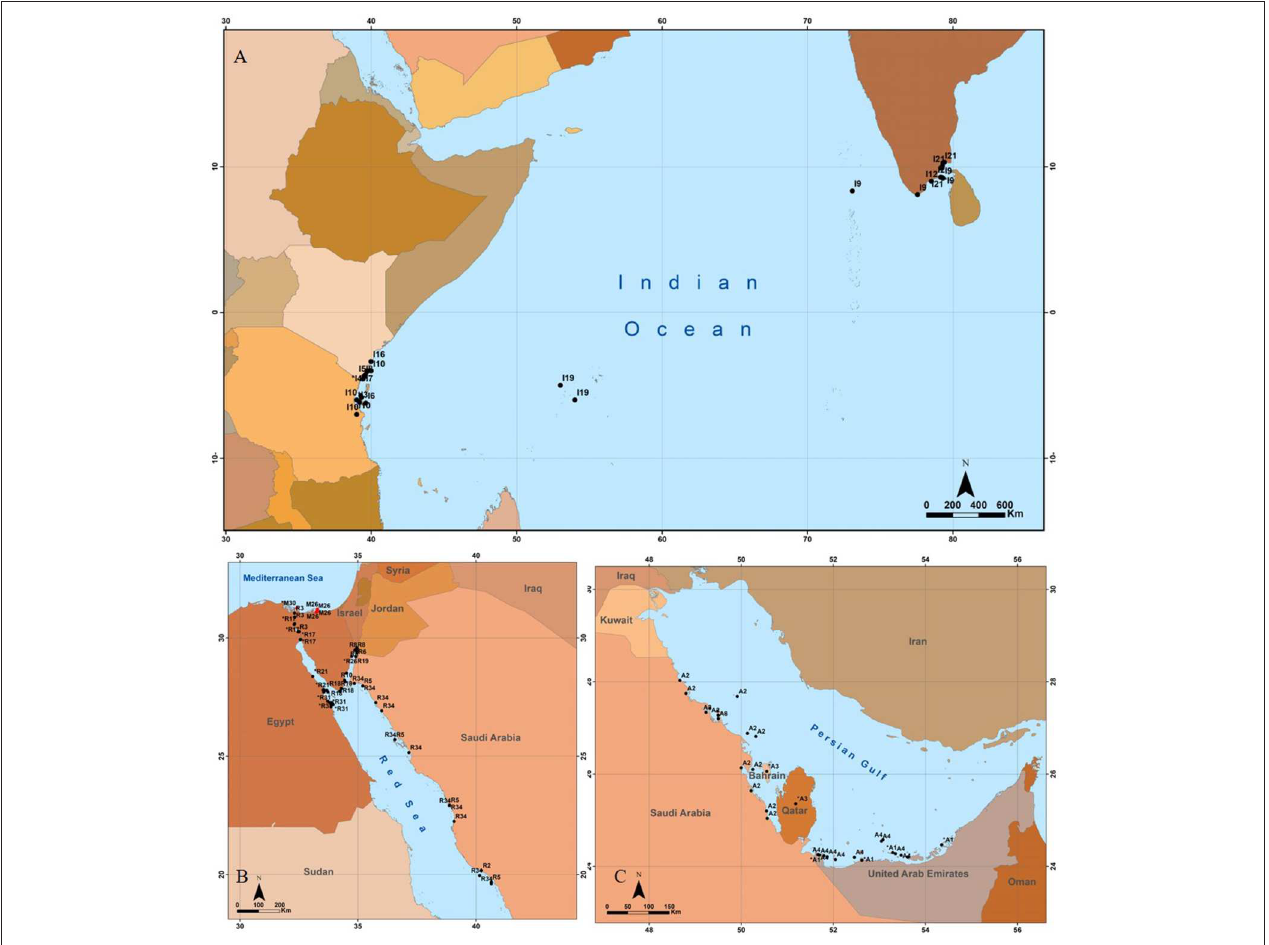
FIGURE 3 | Geographic distribution of published studies on Halophila stipulacea from its native habitat (black color). Shown are known records for the Indian Ocean (A) , Red Sea (B) , and Persian Gulf [ (C) ; numbers for each site refer to the appropriate source ( Table S1 )]. Original coordinates were converted into decimal degrees (D.ddd) in World Geographic System 84 coordinates